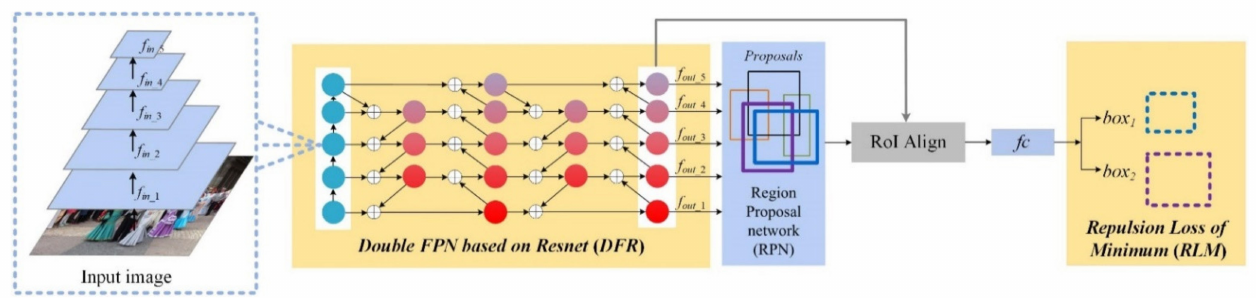
Figure 1. Overall network architecture of MFPN. Feature maps f out_ 1 –f out_ 5 are extracted by ResNet50. Two modules with a yellow highlighted background are our DFR and RLM modules. DFR is the feature fusion module to fuse feature maps with different resolutions. We utilize the weighted feature fusion to sum up feature maps distinguishingly, where “ ⊕ ” represents the fusion process. The predictions box 1 and box 2 are two predictional boxes from the same proposal. Our new loss function RLM can keep predicted boxes away from other ground truths.